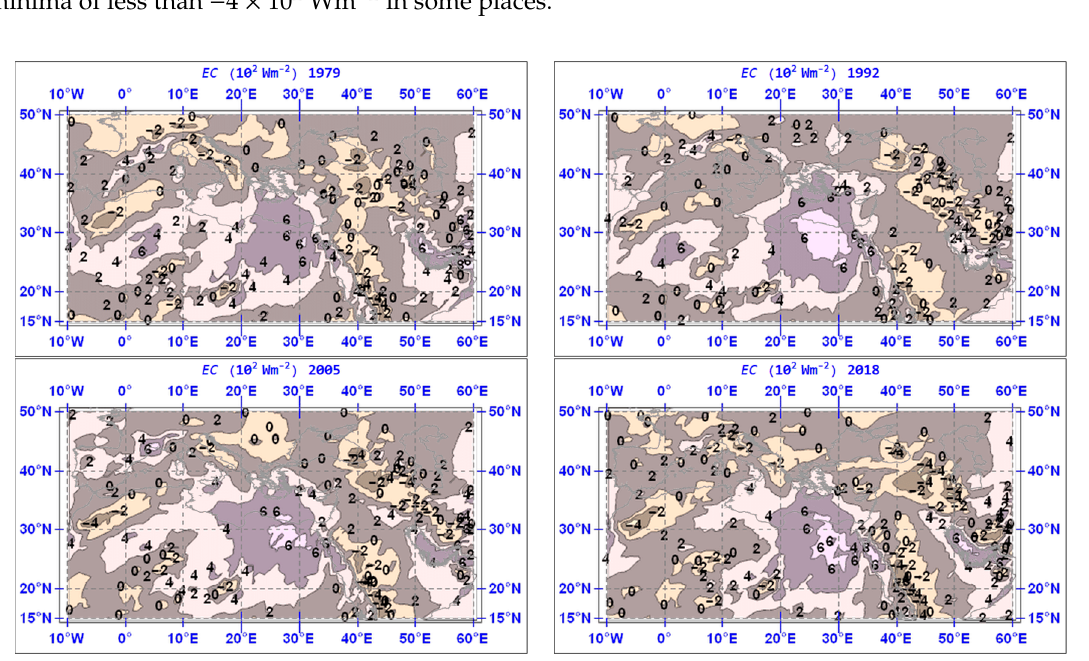
Figure 15. Same as Figure 3, but for EC .